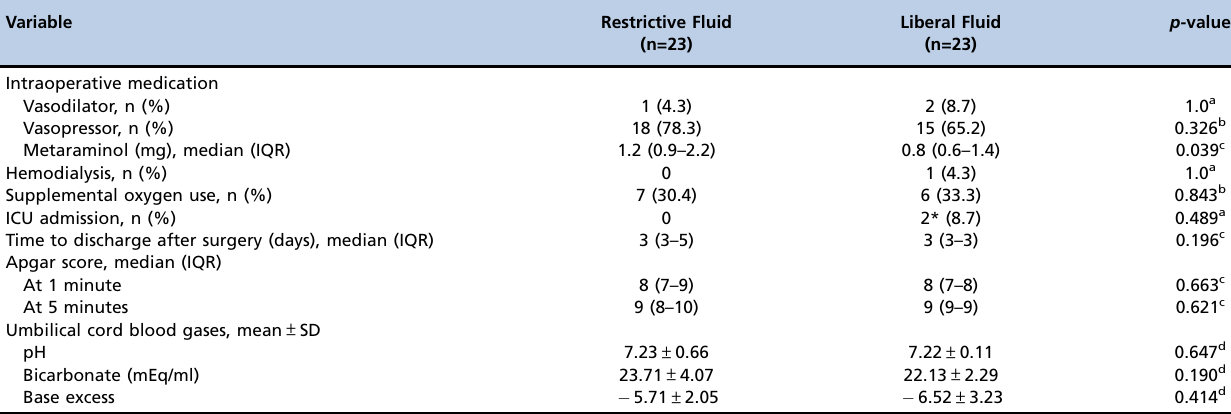
Table S1 - Intraoperative and postoperative variables in patients with preeclampsia, by the type of fluid therapy applied during cesarean section: post-hoc analyses.